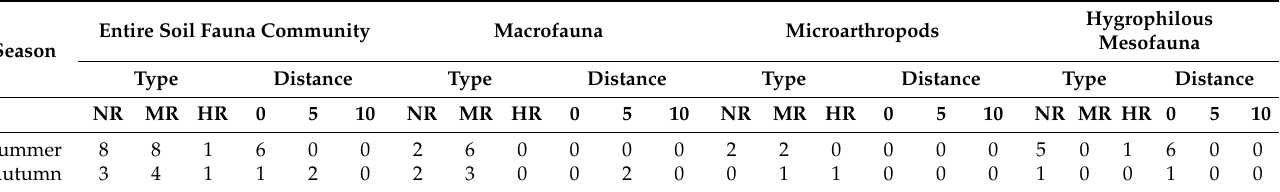
Table A8. Numbers of indicator taxa for revetment types and distances in two